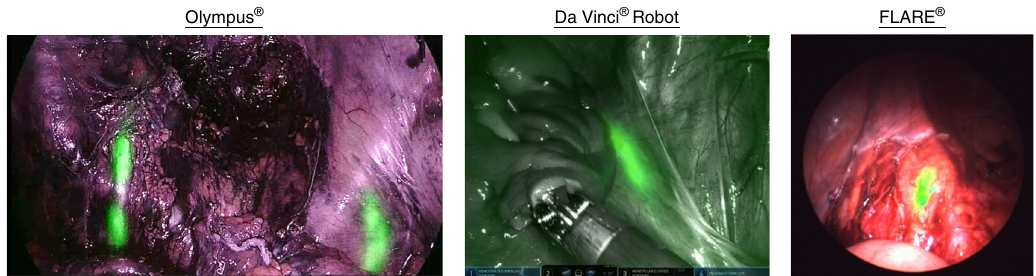
Fig. 1 High sensitivity detection of ZW800-1 near-infrared (NIR) fl uorescence in patients using three different commercial imaging systems. Invisible NIR fl uorescence of ZW800-1 is pseudo-colored in green and overlayed in real-time onto the anatomical